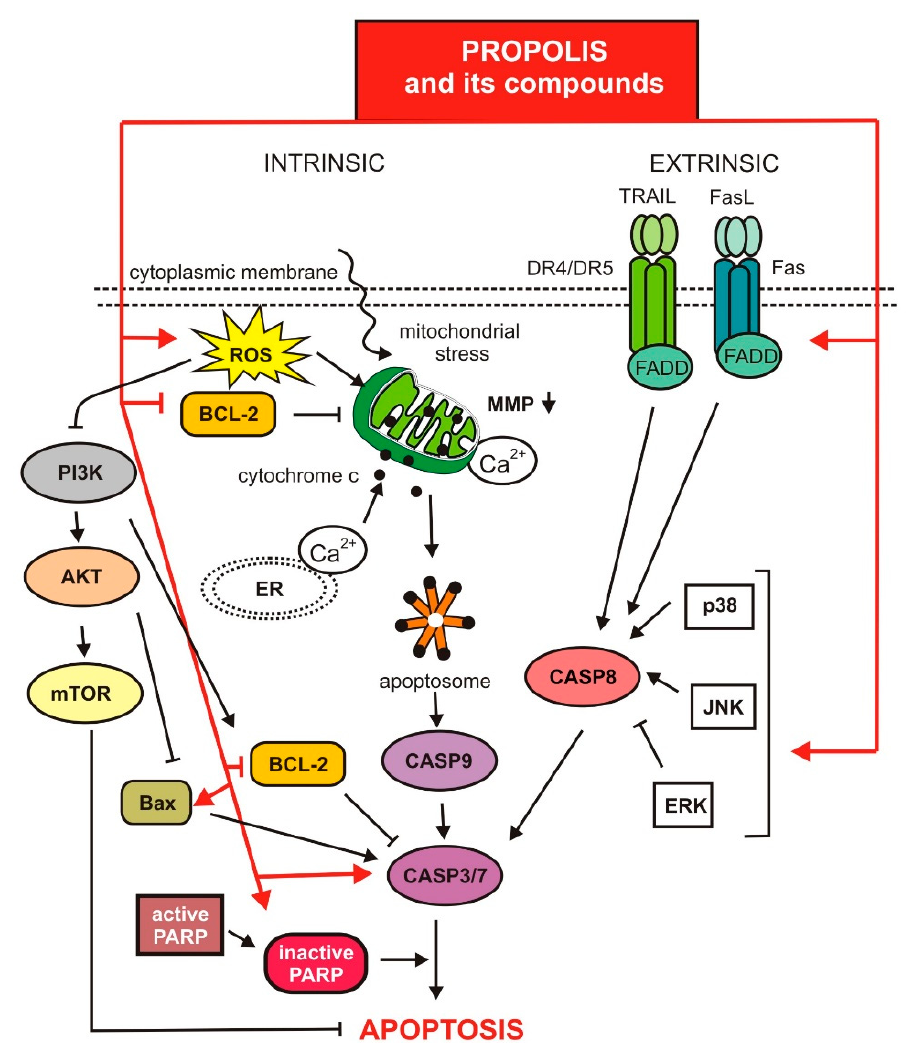
Figure 2. Regulation of apoptosis via propolis and its compounds. Artepillin C, a prenylated derivative of p-coumaric acid, is a phenolic compound of Brazilian green propolis [98,99]. This compound induces apoptosis, as revealed by DNA fragmentation, and increases in cleaved caspase-3 and poly ADP-ribose polymerase in castration-resistant prostate cancer (CRPC) CWR22Rv1 cells [34]. Cell death induced in oral squamous cell carcinoma cells by ArtC, at least in part, was a result of a decrease in survivin levels. Survivin is a member of the inhibitor of apoptosis family and is overexpressed in most human tumors, but undetectable in normal adult tissues